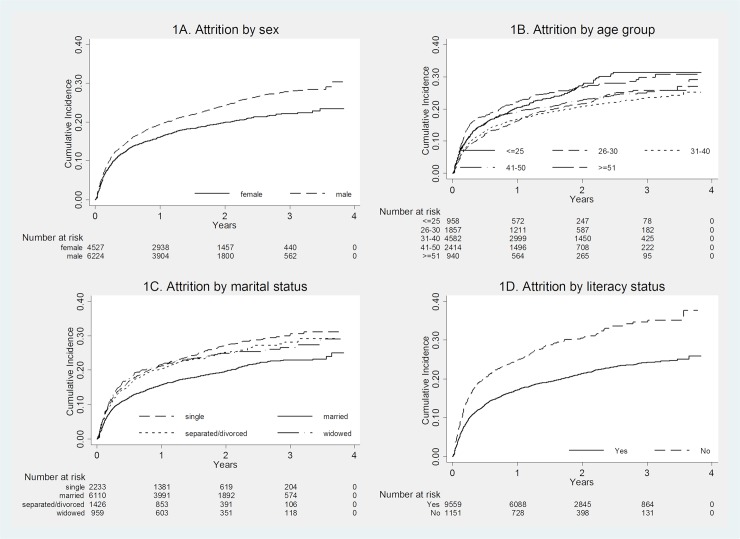
Cumulative incidences of attrition after ART initiation of adult PLHIV in three hospitals specializing for HIV care in Myanmar, 1st June 2013 to 30th June 2016.ART, anti-retroviral therapy; HIV, human immunodeficiency virus; PLHIV, people living with HIV.